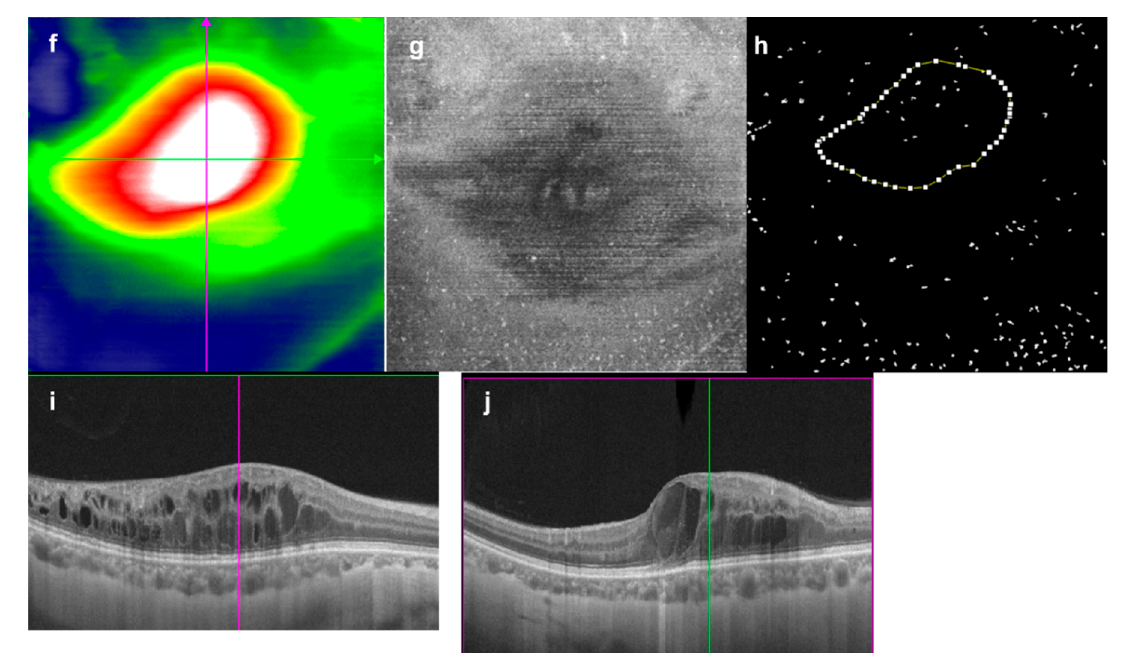
Figure 1. MLC density decreased significantly in the edematous region ( a – e ) and ( g – j ) from two different acute patients with retinal edema. ( a , f ) Retina thickness map. ( b , g ) En face 5 μ m OCT slabs above ILM with hyperreflective dots representing MLCs. ( c , h ) Binarized image with the edema region boundaries outlined. The edema region marked by red edge in ( a , f ). ( d , e , i , j ) OCT B-scans showing the retinal edema. The colored lines in ( d , e , i , j ) corresponding to the lines with same color in ( a , f ), respectively.